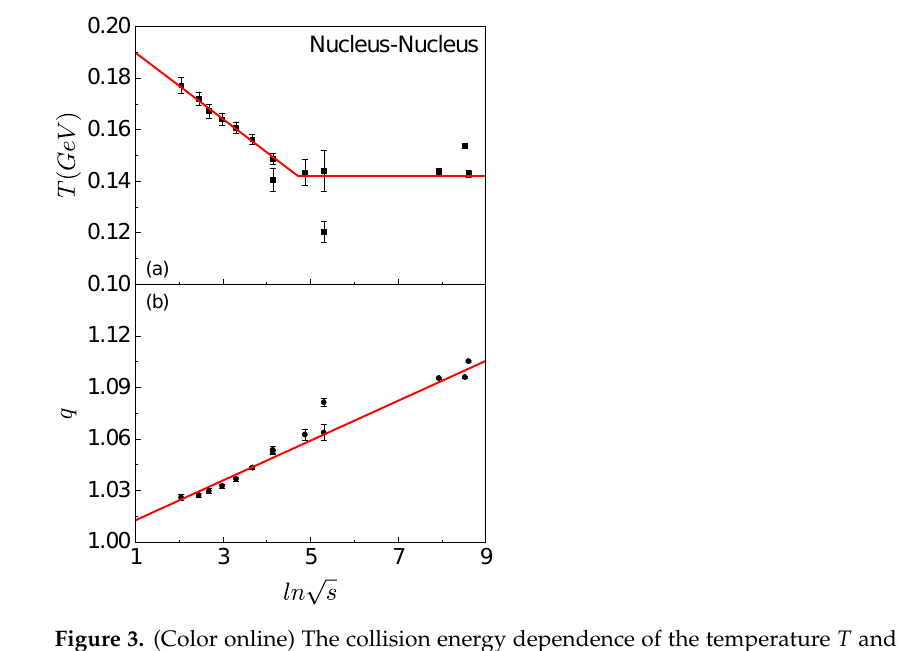
Figure 3. (Color online) The collision energy dependence of the temperature T and nonextensive parameter q for the collision systems in Figures 1 and 2 at the most central collisions. See text for the lines.